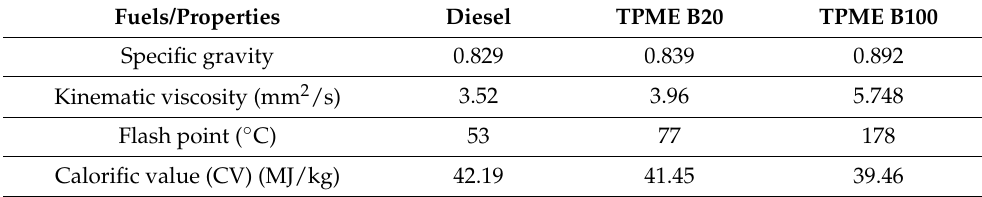
Table 1. Properties of liquid fuels.